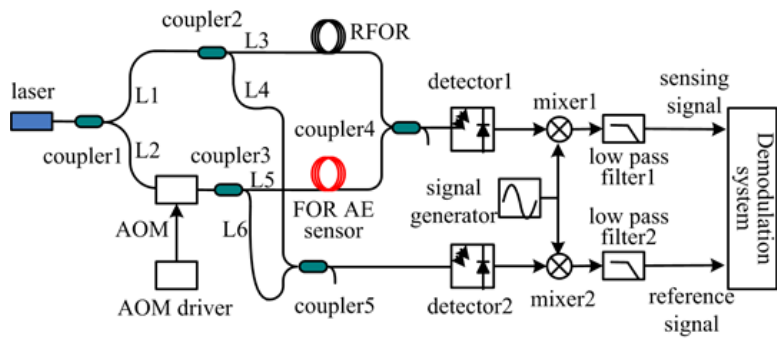
Figure 5. FOR AE system diagram.